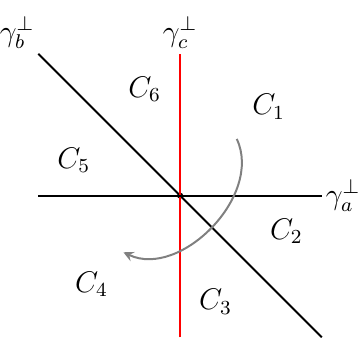
Figure 8. The scattering diagram of asymptotic chambers near the limiting ray in the A 2 , 1 cluster algebra. We projected down onto the plane perpendicular to the limiting ray, g labeled the